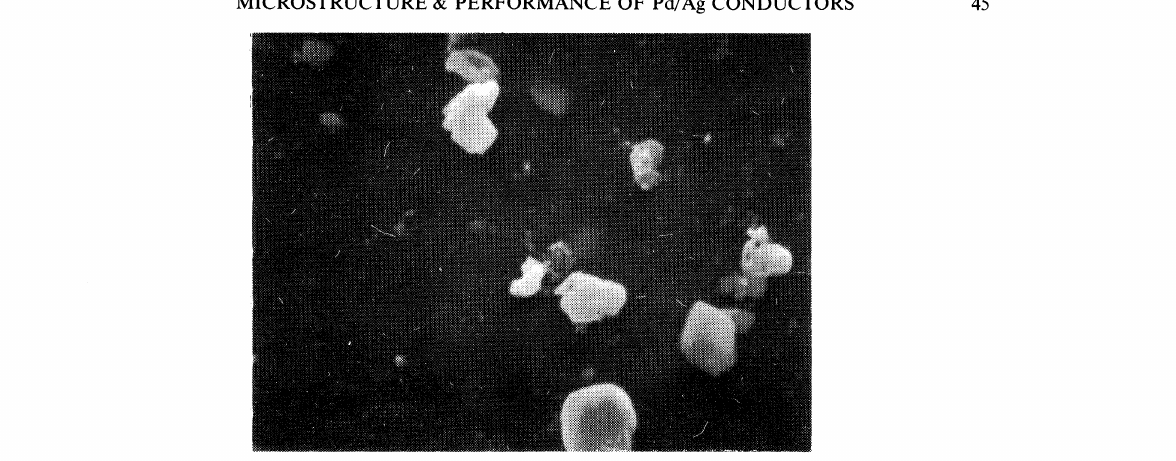
Particles present in unfired ink; the smallest grains are identified as Pck the medium sized grains are due to Ag, the largest particles are rich in Pb and Si and can be associated with the glass frit.